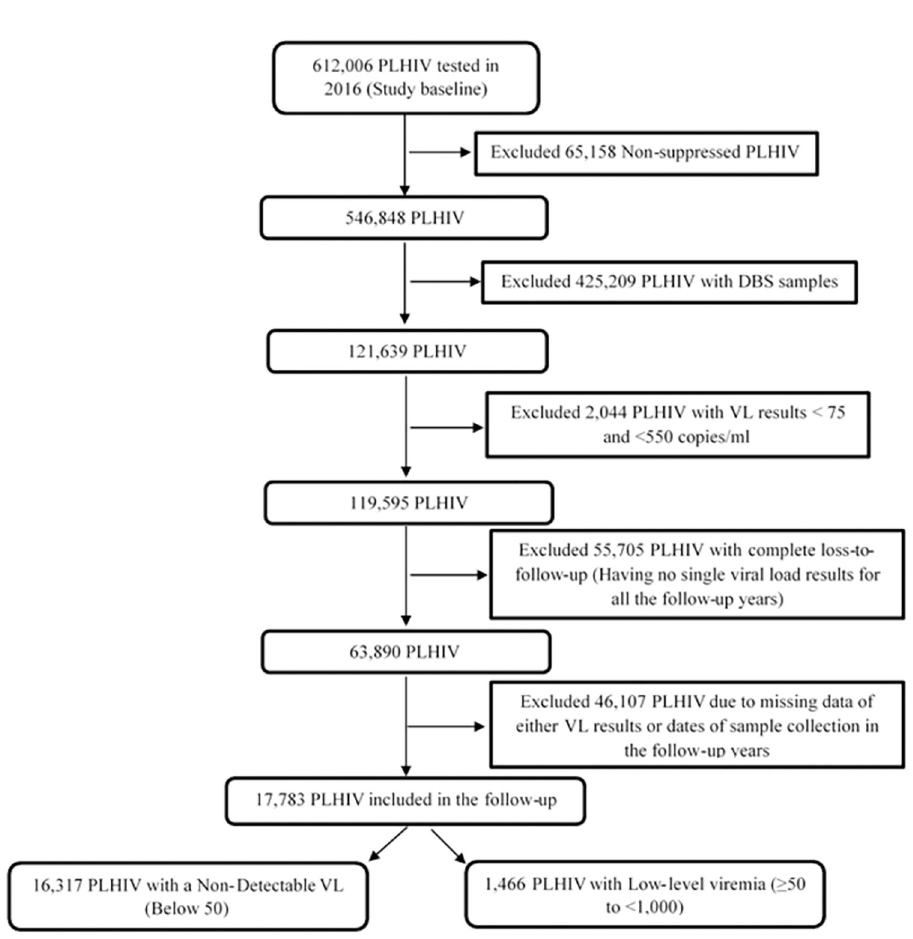
Fig 2. Participants included in the study (Study